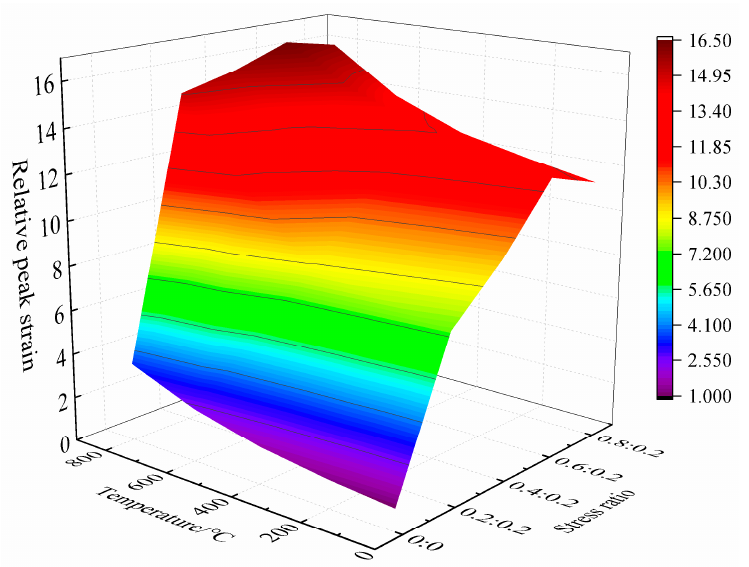
Figure 10. Relative peak strain of concrete under high temperature and biaxial unequal lateral pres-